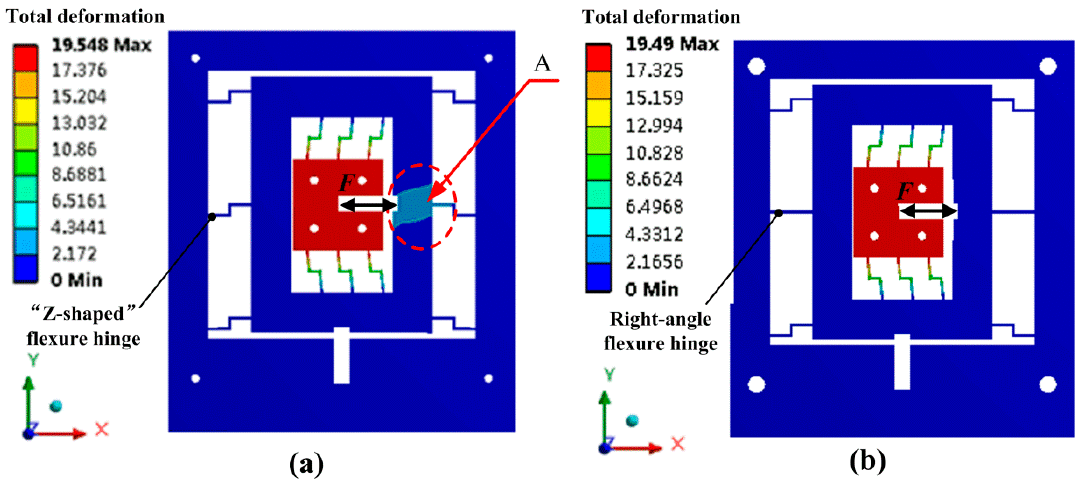
Figure 4. FEM static results of the platform: ( a ) only “Z-shaped” flexure hinges; ( b ) with right-angle flexure hinges.